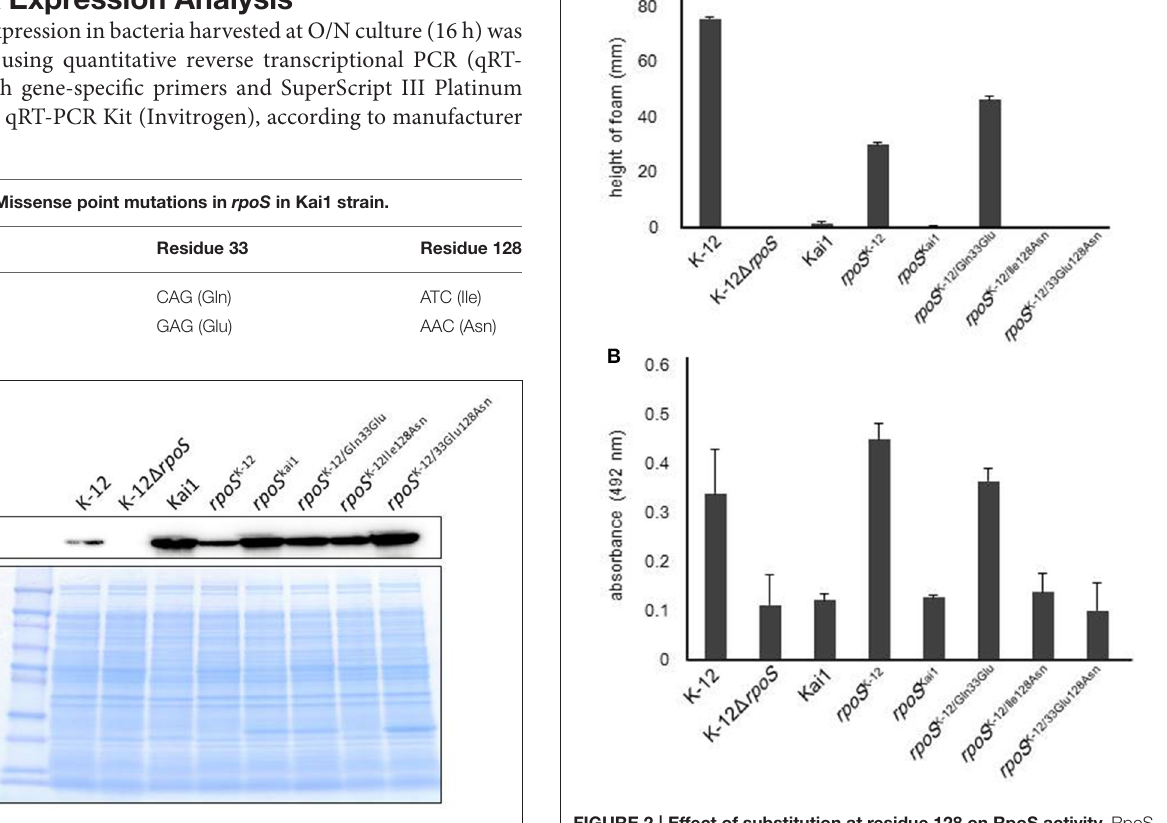
FIGURE 1 | Effect of substitution at residue 128 on RpoS expression. RpoS expression in rpoS variants harboring mutation(s) in rpoS Kai1 ( rpoS K − 12 / Gln33Glu , rpoS K − 12 / Ile128Asn , and rpoS K − 12 / Glu33Asn128 ) and in the Kai1 strain. The experiment was conducted thrice, and representative images are shown. LC, loading control. The loading control image depicts a part of Coomassie stains of SDS-PAGE gels.